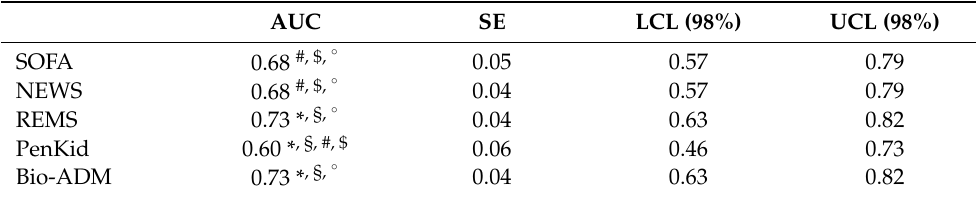
Table 4. ROC curves for scores and